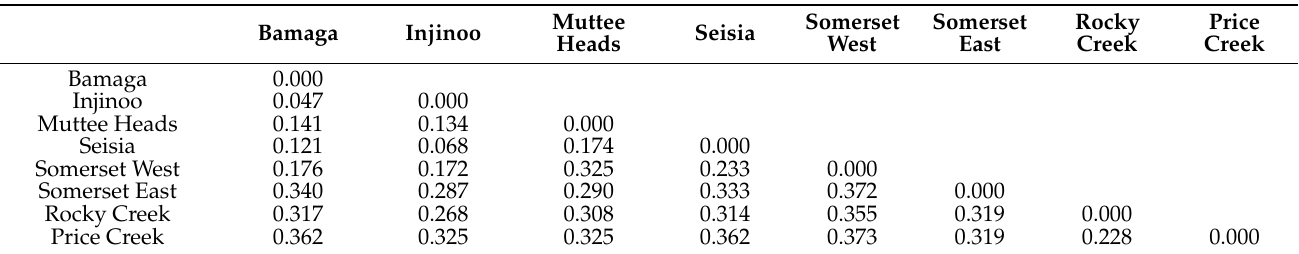
Table 3. Pairwise population F ST values (below diagonal) calculated using Wrights F-statistics between eight populations of S. lanceolatum from Cape York (Queensland, Australia).